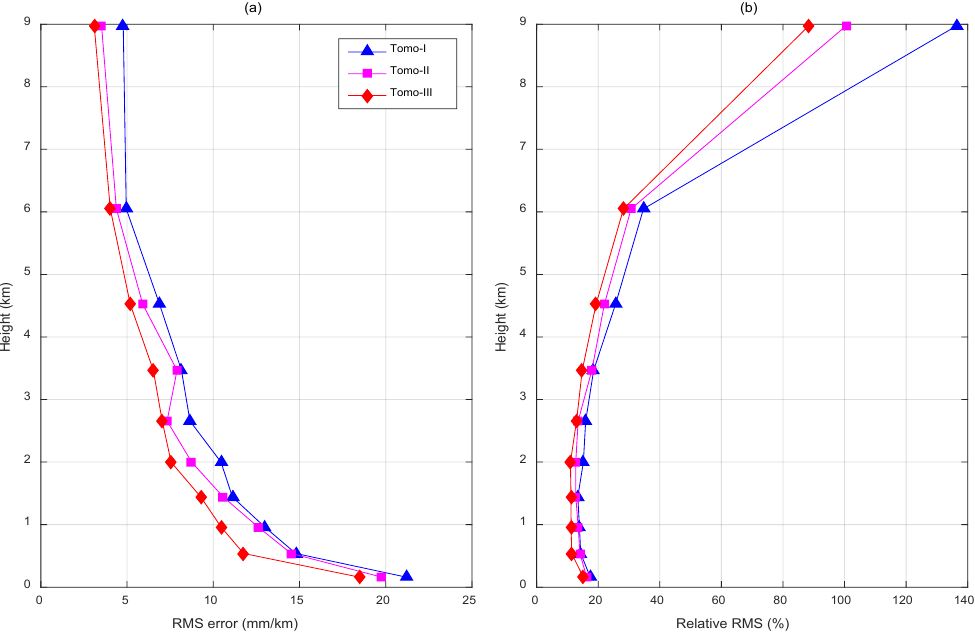
Figure 7. Changes of the ( a ) RMS error and ( b ) relative RMS of the wet refractivity differences between ERA5 and tomography at different vertical layers.